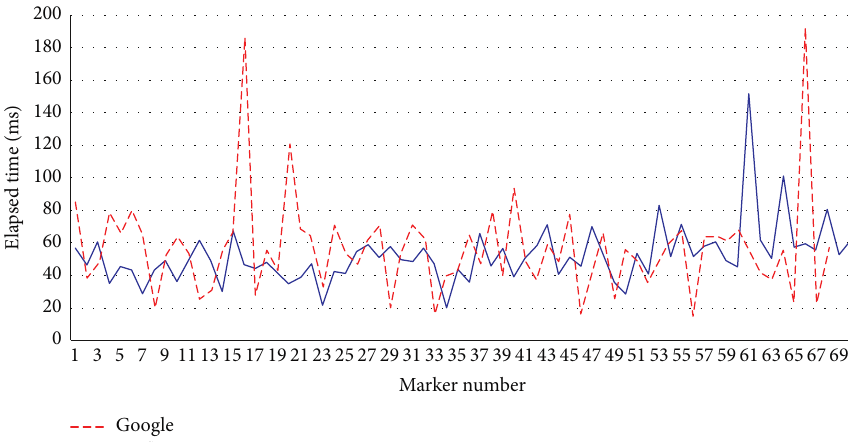
Figure 22: The elapsed times to locate and display 70 markers using Leaflet and Google Maps.